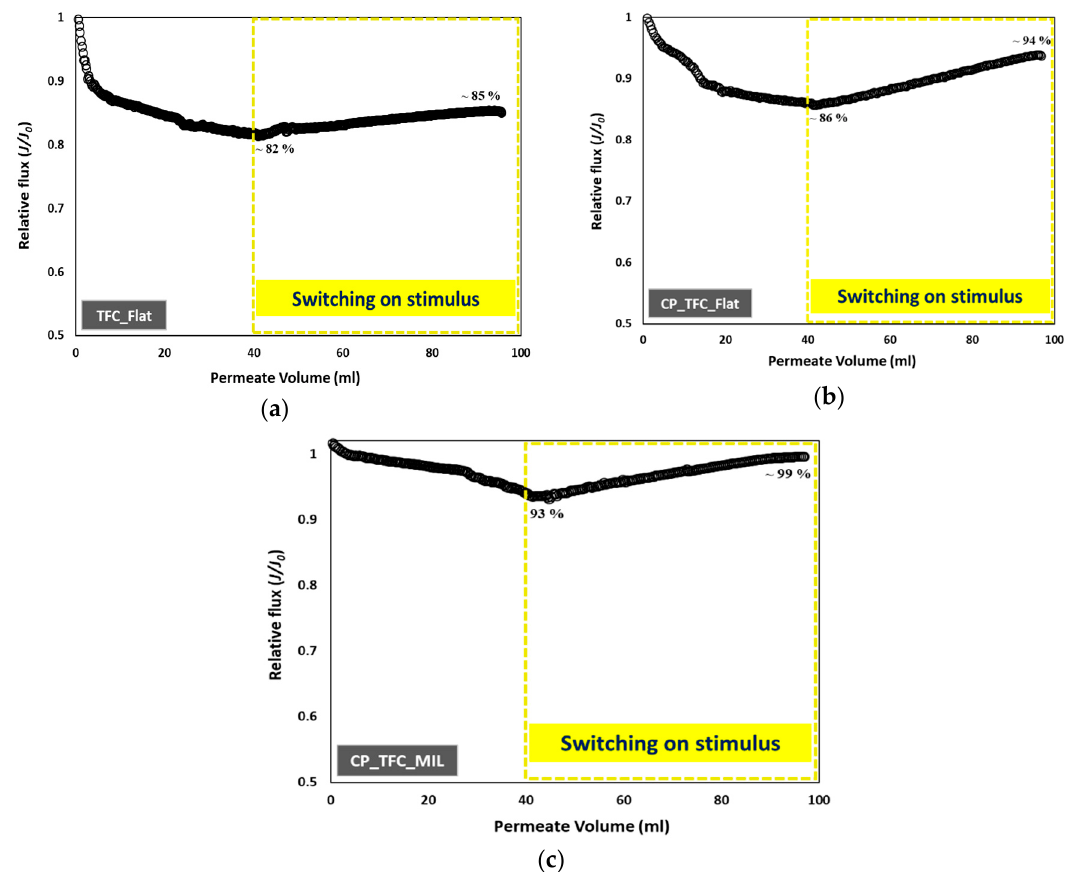
Figure 9. Influence of stirring, as an added stimulus, on colloidal fouling of flat and micro-patterned membranes by silica nanoparticles (50 nm) in unstirred dead-end filtration conditions, with constant pressure ( ~ 17 bar) and ambient temperature (23–25 °C). The experiments were repeated at least two times, employing a virgin membrane for each; the relative error was <12%. ( a ) flat pristine TFC membrane (TFC_Flat); ( b ) flat surface modified membrane (CP_TFC_Flat); ( c ) micro-patterned surface modified membrane (CP_TFC_MIL).